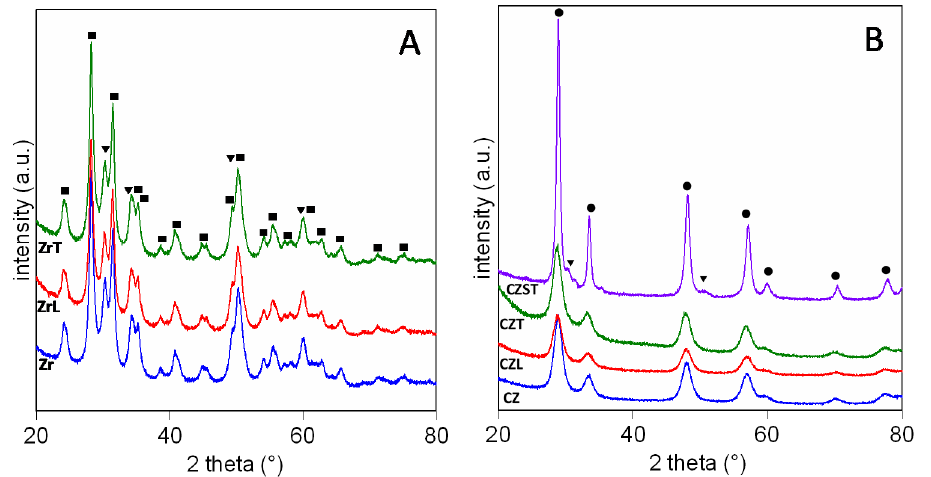
Figure 1. X-ray di ff raction (XRD) profile of ( A ) zirconia-based materials (ZrO 2 monoclinic, (cid:4) ; ZrO 2 Figure 1. X-ray diffraction (XRD) profile of ( A ) zirconia-based materials (ZrO 2 monoclinic,  ; ZrO 2 tetragonal, (cid:72) ); and ( B ) ceria–zirconia-based materials (Ce 0.8 Zr 0.2 O 2 , • ; ZrO 2 tetragonal, (cid:72) tetragonal,  ); and ( B ) ceria–zirconia-based materials ( Ce 0.8 Zr 0.2 O 2 ,  ; ZrO 2 tetragonal,  ).